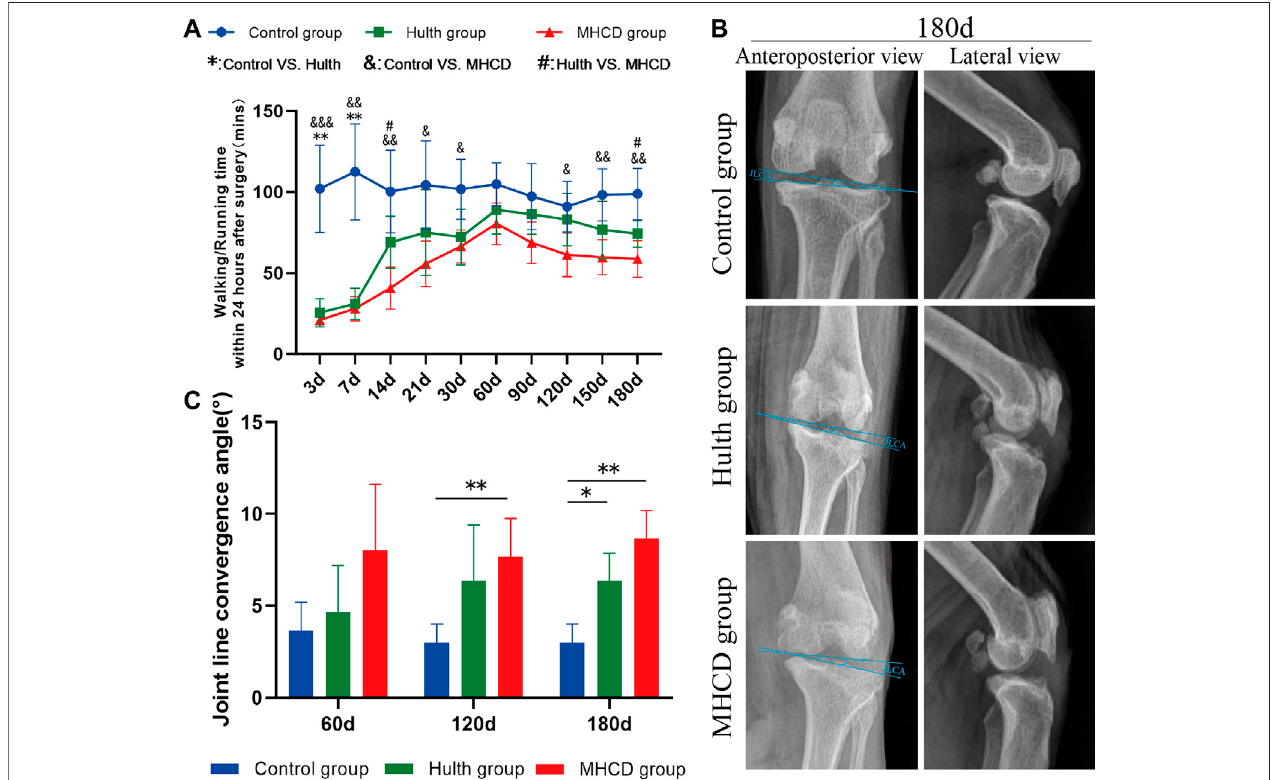
FIGURE3| EvaluationofmotoractivityandpostoperativeX-raysinthethreegroupsofrhesusmacaques. (A) Motoractivitywithin24 haftersurgery. (B) Representative X-rays of the knee joints on Day 180. (C) . Changes in joint convergence angles of the left knee. * p < 0.05, ** p < 0.01, *** p < 0.001. Data are presented as the mean ± SD.